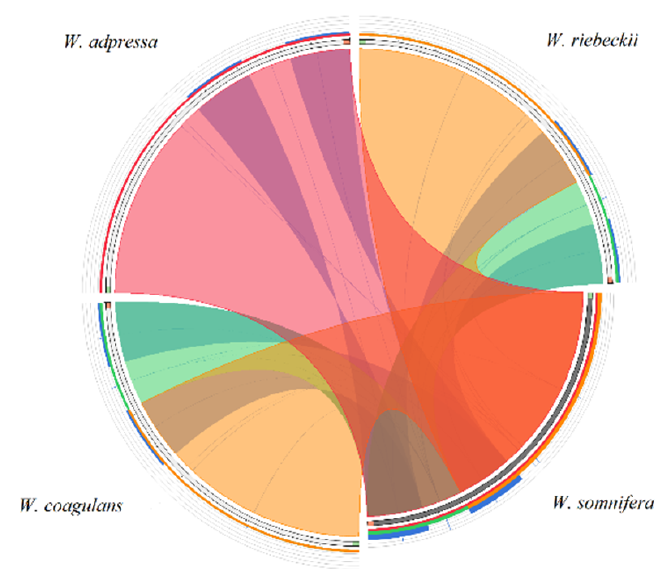
Figure 1. Structural comparison of Withania plastomes showing a high level of synteny and the lack of large rearrangements. The start and end points of the sequences are marked by green and orange blocks. The colored blocks outside the sequences refer to the score / max bit core ration, with green ≤ 0.50, orange ≤ 0.75, and red > 0.75. Blue blocks and chords represent the inverted repeats (IRs).